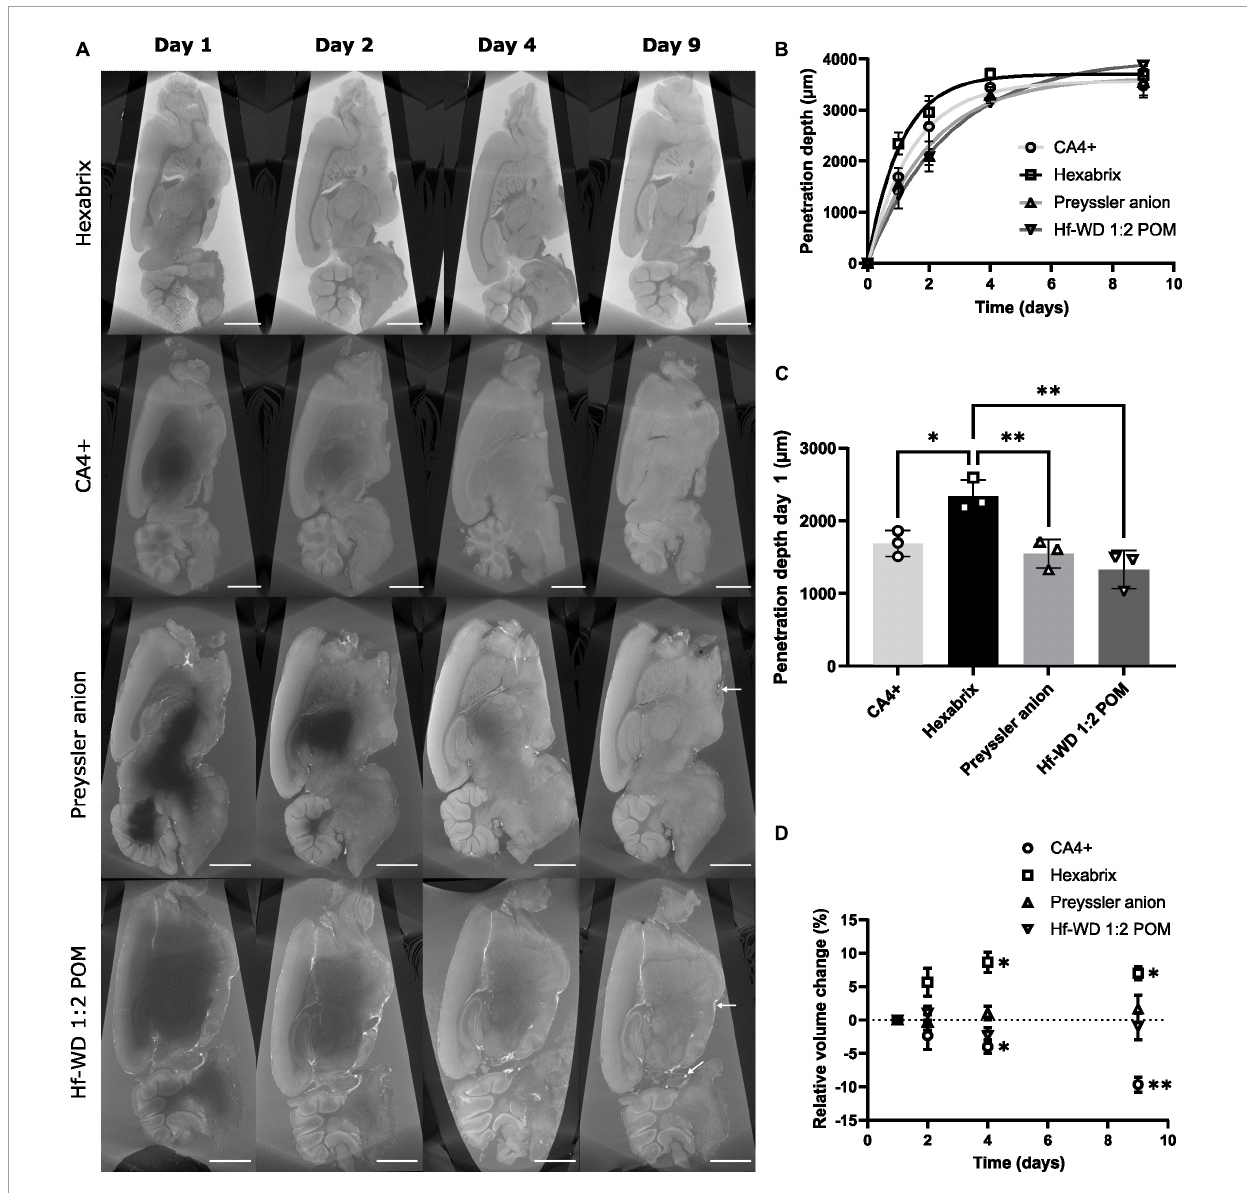
FIGURE4 Penetration depth over time per CESA. (A) Typical CECT cross-sections of murine hemispheres that were stained with CA4+, Hexabrix, Preyssler anion or Hf-WD 1:2 POM imaged in fast acquisition mode after 1, 2, 4, and 9 days of staining ( n = 3 per CESA) (scale bar = 1 mm). White arrows (Preyssler anion and Hf-WD 1:2 POM, day 9) indicate blood vessels (empty and filled). (B) Evolution of the approximated penetration radius over time (mean ± SD). Fitted exponential decay function: r p ( t ) = R e − ( R e ∗ e xp ( − k t ) ) , with r p = depth of penetration front, R e = asymptote and k = growth rate. (C) Bar plot comparison between penetration depths after one day of staining (data points = individual samples, whiskers = standard deviation, n = 3). Ordinary One-Way ANOVA ( α = 0.05, p -value = 0.0023) followed by Tukey’s multiple comparisons test (Hexabrix vs CA4+: p -value = 0.0243, 95%CI [0.0914, 1.22]; Hexabrix vs Preyssler anion: p -value = 0.0085, 95%CI [0.2308, 1.359]; Hexabrix vs. Hf-WD 1:2 POM: p -value = 0.0019, 95%CI [0.4495, 1.578]). (D) Relative total volume change over time during staining for each CESA ( n = 3). Two-Way ANOVA followed by Dunnett’s multiple comparisons test vs day 1 (CA4+: Day 3: p -value = 0.0387, 95%CI [ − 0.498, − 7.5]; Day 4: p -value = 0.0091, 95%CI [ − 5.62, − 13.71], Hexabrix: Day 3: p -value = 0.019,6 95%CI [3.318, 14.02]; Day 4: p -value = 0.013, 95%CI [3.498,